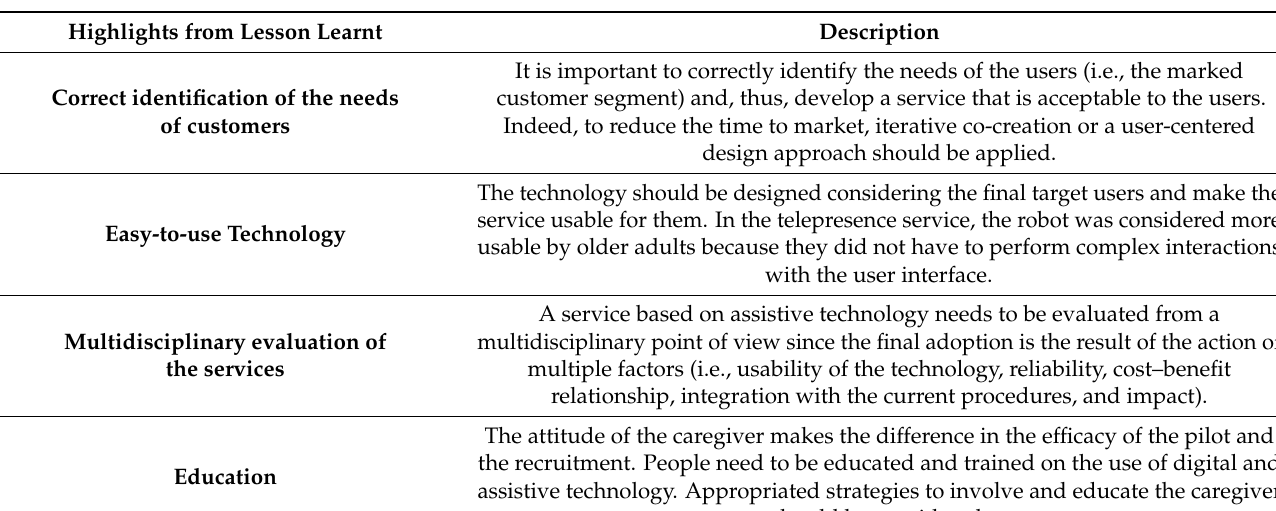
Table 3. Highlights from the experience: results of the reflection